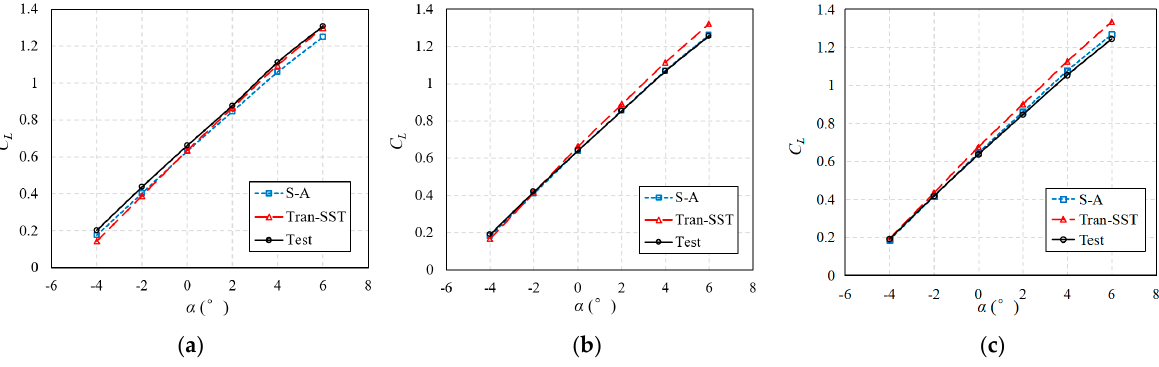
Figure 17. Comparison of lift coefficient curves obtained by different methods: ( a ) v = 6.4 m/s; ( b ) v = 9.0 m/s; ( c ) v = 11.0 m/s.